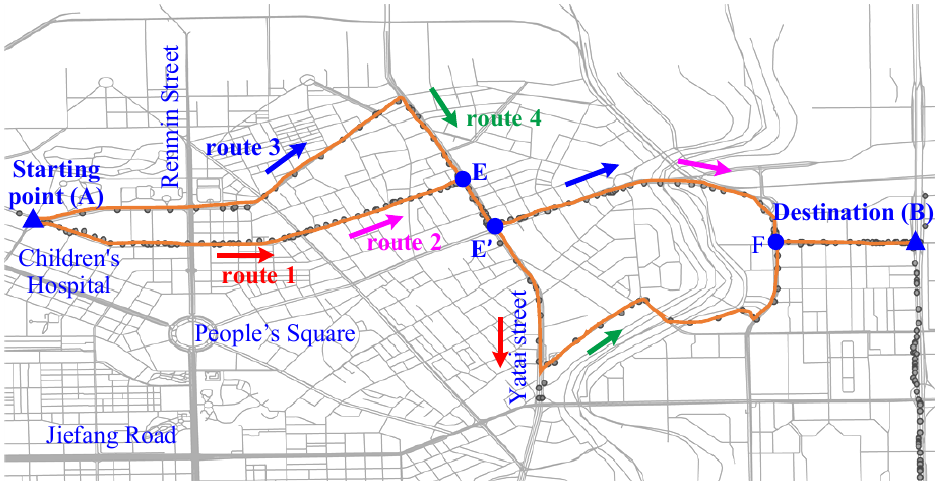
Figure 7. Schematic diagram of the area.